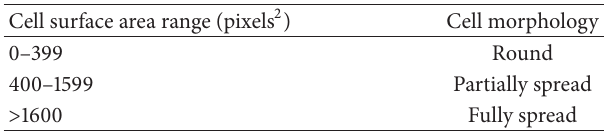
Table 1: Classification of hDPSC morphology in pixels 2 based on cell surface area